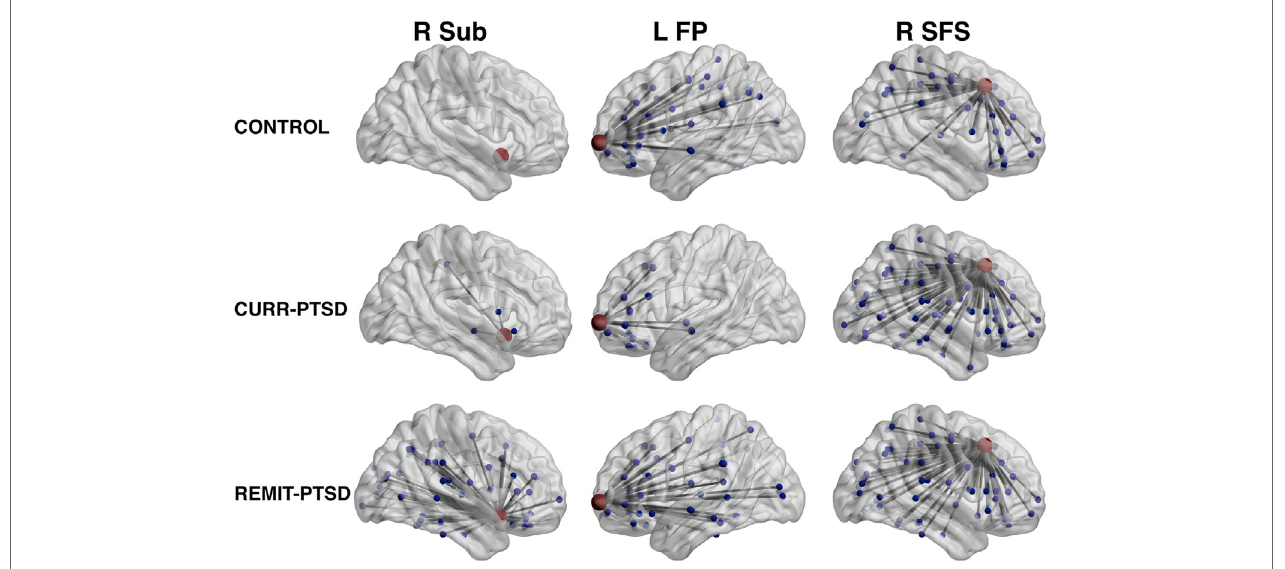
FigUre 1 | Between-group differences of centrality measures. Left column, REMIT-PTSD (lifetime but no current PTSD group) group showed larger centrality in right subcallosal gyrus (R Sub) than both CURR-PTSD (current PTSD group) and CONTROL (control group with trauma exposure) groups. Middle column, both REMIT-PTSD and CONTROL groups showed larger centrality in left frontal pole (L FP) than CURR-PTSD group. Right column, both REMIT-PTSD and CURR-PTSD groups showed larger centrality in right superior frontal sulcus (R SFS) than CONTROL group. For observation purpose, the regions of interest (red), their connected nodes (blue), and the connections (gray) were shown. Node size was scaled by degree centrality.